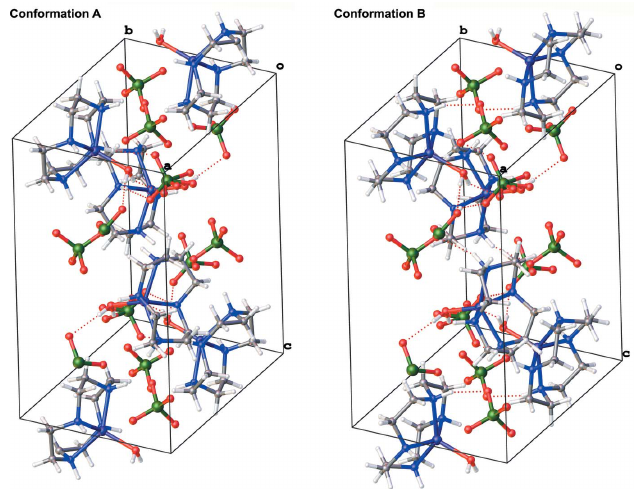
Figure 2 A view of the crystal packing of the title complex. Dashed lines denote the hydrogen bonds.